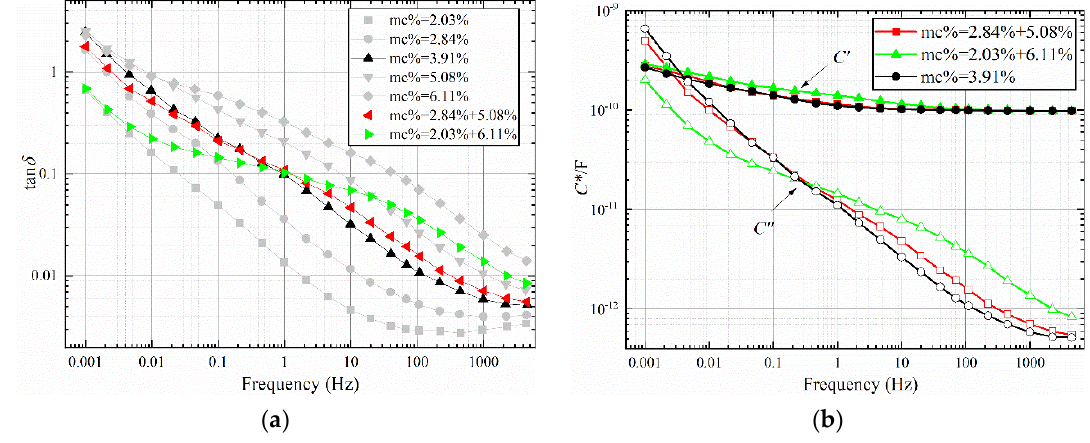
Figure 8. FDS characteristic curve with an average water content of 4%. ( a ) tan δ - f , ( b ) C *- f